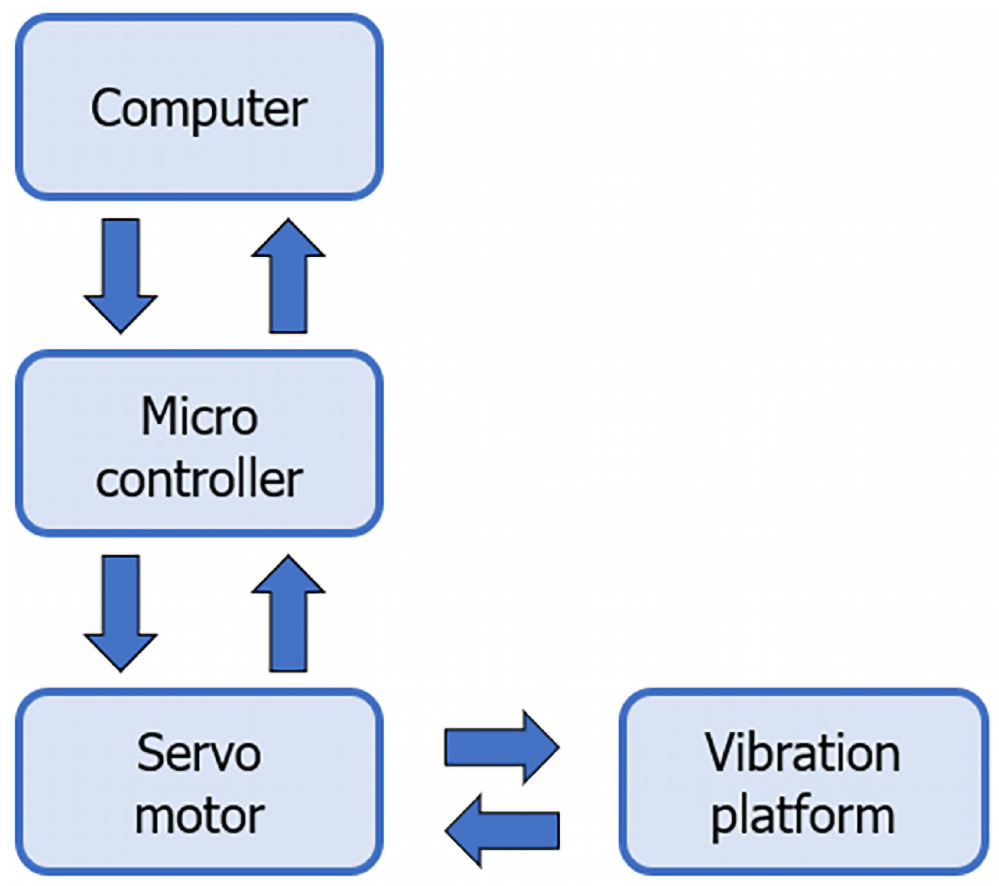
Fig 5. Control flow